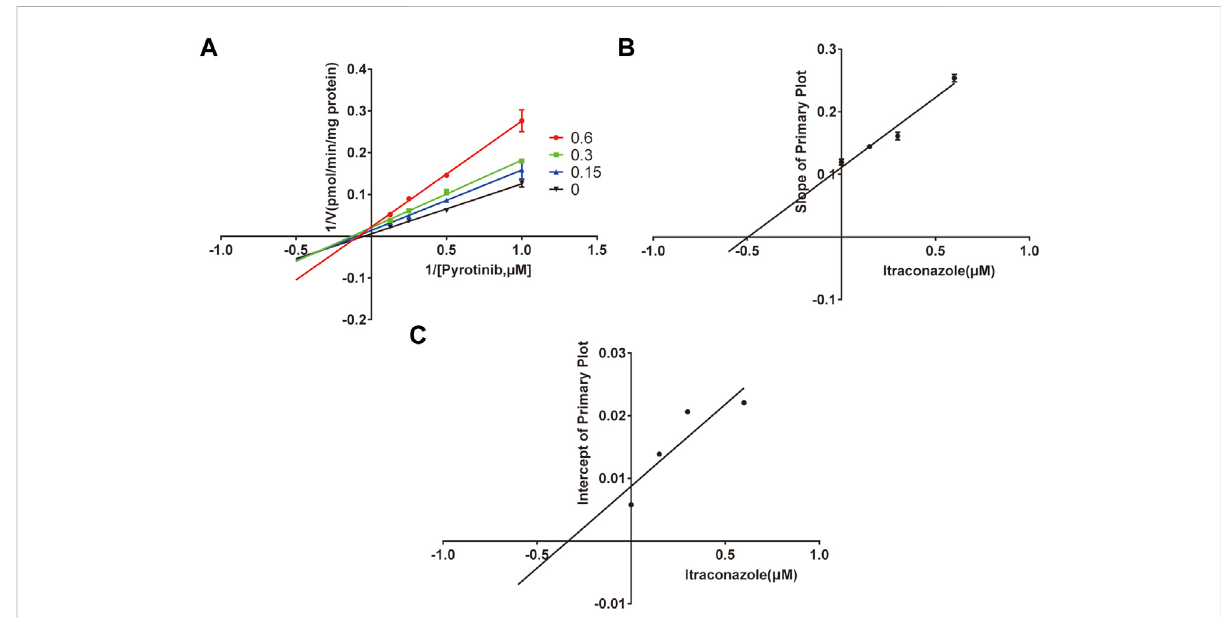
FIGURE 5 The Primary Lineweaver-Burk plots of itraconazole inhibition on pyrotinib (A) ; Slope of the primary plot of itraconazole (B) ; Intercept of the primary plot of itraconazole (C) (values are means ± standard deviations, n =3).